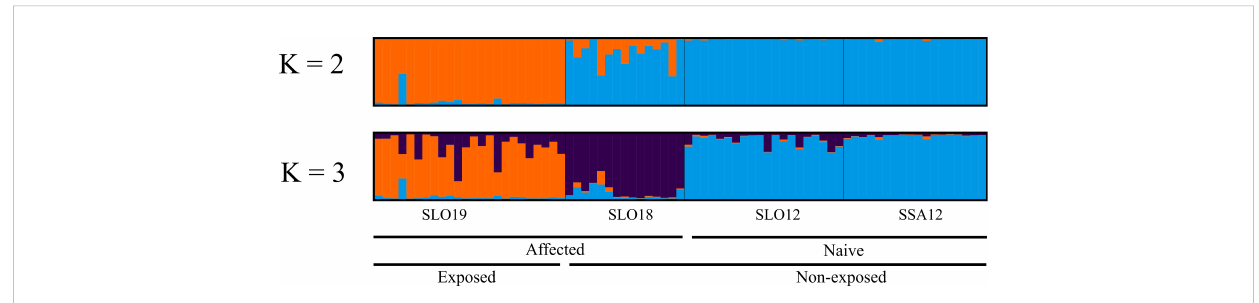
FIGURE 2 Population structure of Cerastoderma edule beds analysed with STRUCTURE with 110 PCAND dataset for K = 2 and K= 3). Each individual is represented by a vertical bar and its colour is proportional to the posterior probability assigned to each